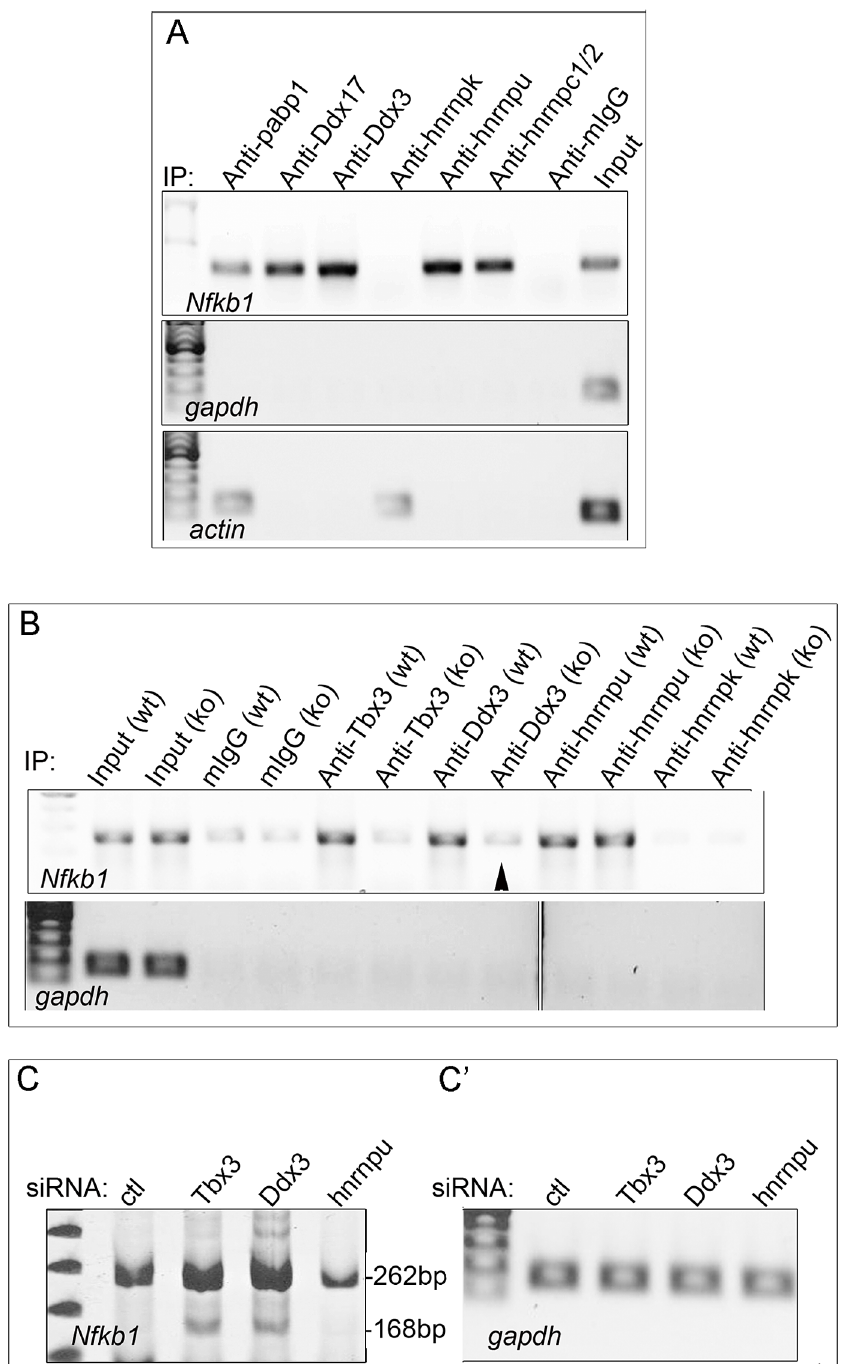
Figure 6. Tbx3 binding partners associate with the Nfkb1 mRNA that is alternatively spliced in response to Tbx3, and a subset require Tbx3 to bind this mRNA. A) RNA-IP with anti-Tbx3 on embryo lysates using antibodies against Tbx3 interacting proteins to test binding to the Nfkb1 transcript which is differentially spliced in response to Tbx3 in mouse limb. Actin and Gapdh are negative controls. Note that not all Tbx3 interactors bind this mRNA. B) RIP/RT-PCR testing Tbx3 interactors for binding of the Nfkb1 mRNA in Tbx3 wild type (wt) and null (ko) murine embryonic fibroblasts (MEFs). Ddx3 requires Tbx3 to bind the Nfkb1 mRNA (arrowhead) but hnrnpu does not. C) RT-PCR assay of splice variants in control, Tbx3 and Ddx3 siRNA knockdown MEFs. Knockdown of Ddx3 results in the same alternative splicing of Nfkb1 exon 11 as Tbx3 knockdown, whereas knockdown of hnrnpu decreases the total amount of Nfkb1 transcript but has no effect on exon 11 splicing. C 9 ) Gapdh control RT-PCR.